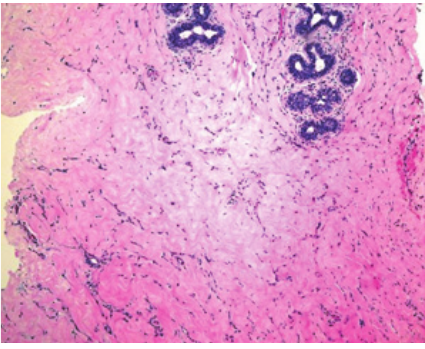
Figure 3: Pathology report: PASH-like